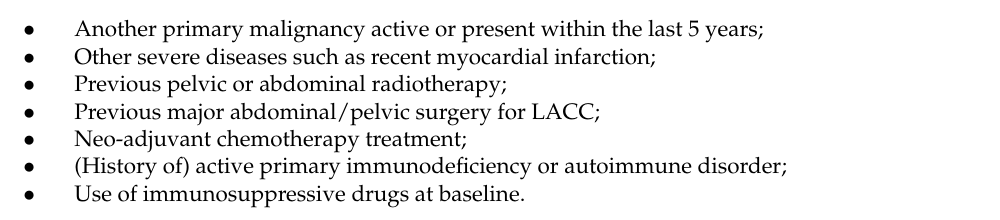
Table 1. Inclusion and exclusion criteria for participation in the PROTECT trial.